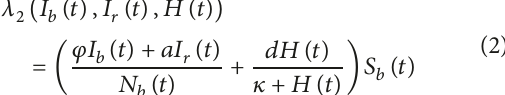
to the latently infected class at the transmission rate defined